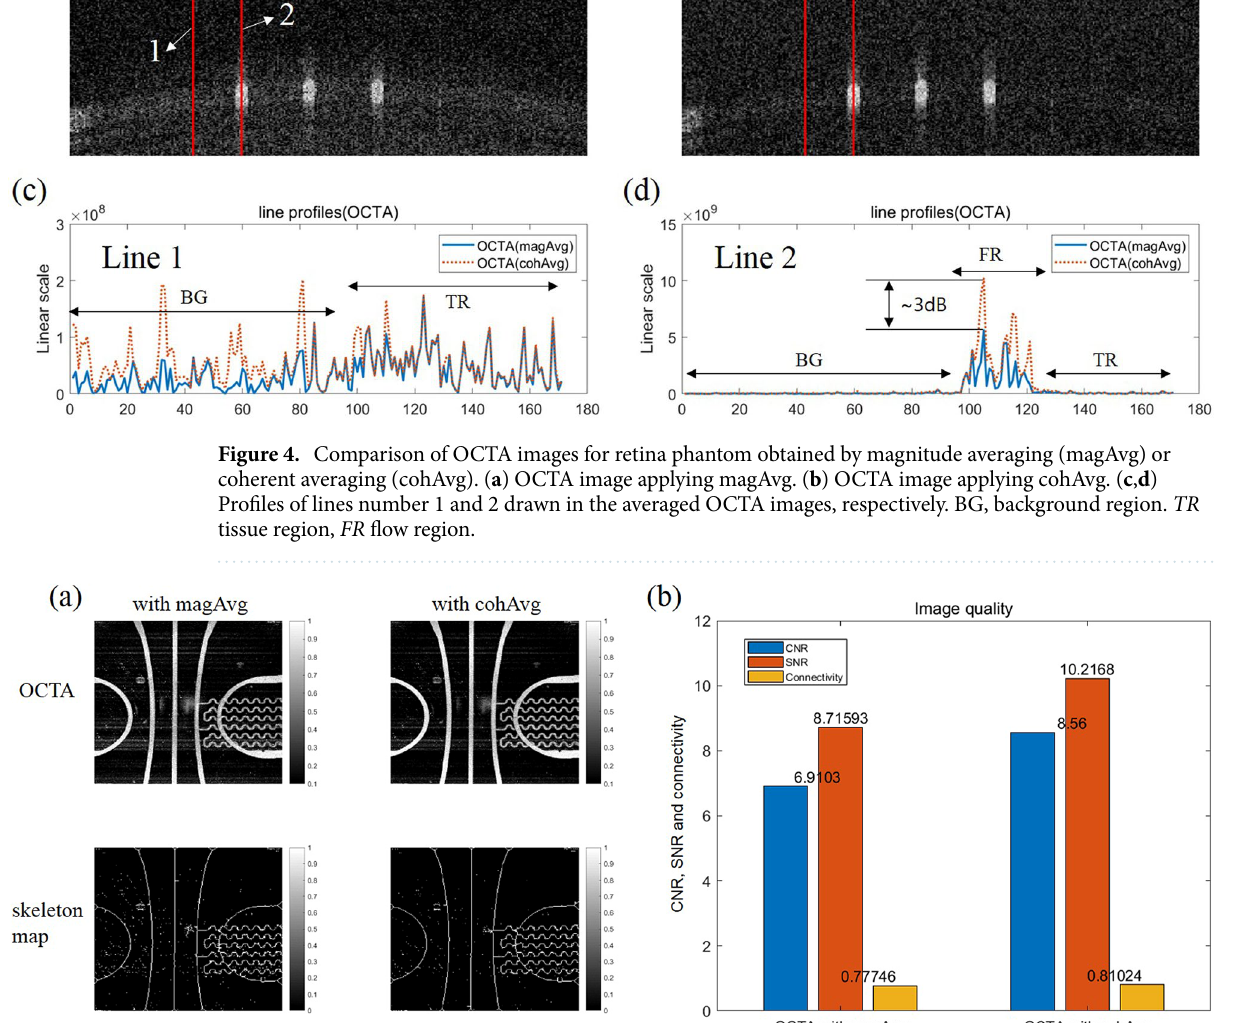
Figure 5. Assessment of en face OCTA images for retina phantom obtained by magnitude averaging (magAvg) or coherent averaging (cohAvg). ( a ) En face OCTA images with magAvg and cohAvg (top row) and their skeleton maps (bottom row). ( b ) Contrast-to-noise ratio (CNR), signal-to-noise raito (SNR), and vessel